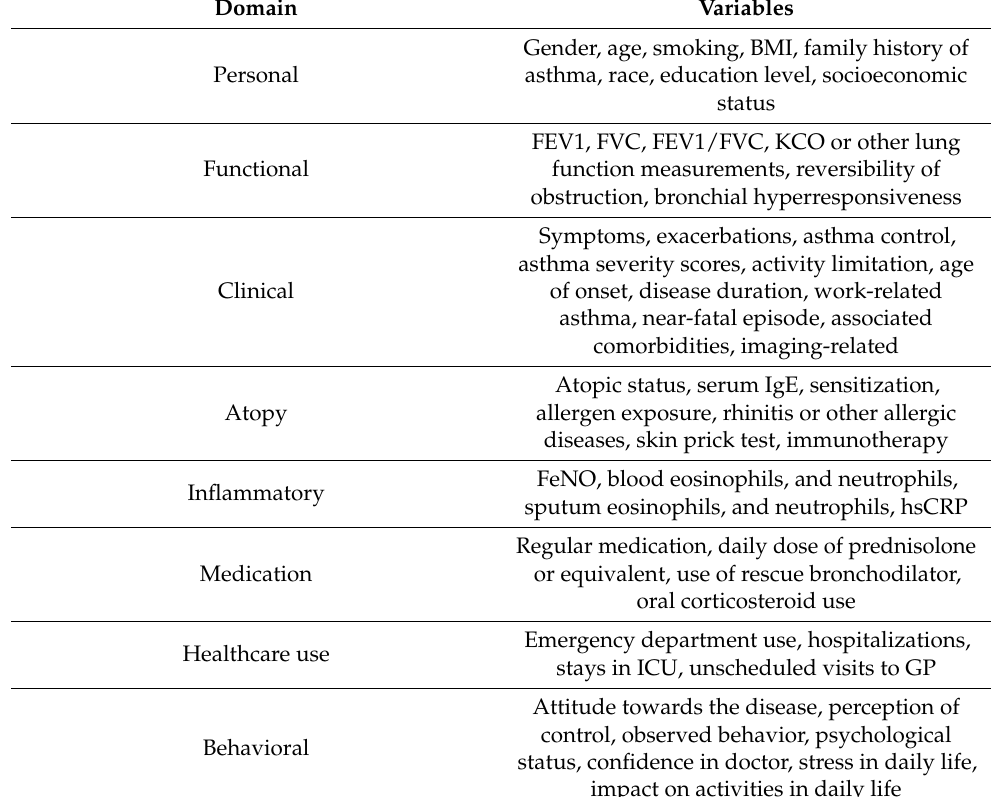
Table 2. List of variables covered by each